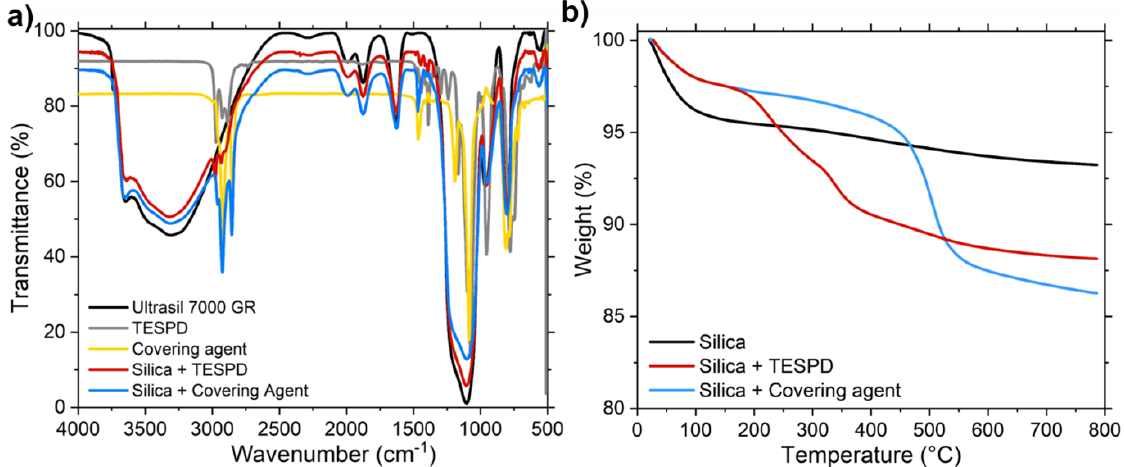
Figure 2. ( a ) Fourier Transform Infrared Spectroscopy (FTIR) analysis of the of the unmodified and modified silicas with bis(triethoxysilylpropyl) disulfide (TESPD) (red line) and covering agent (blue line), TESPD (grey line) and covering agent (CA) (yellow line) and ( b ) thermogravimetric analysis (TGA) curves of the unmodified and modified silicas with TEPSD (red line) and covering agent (blue line).